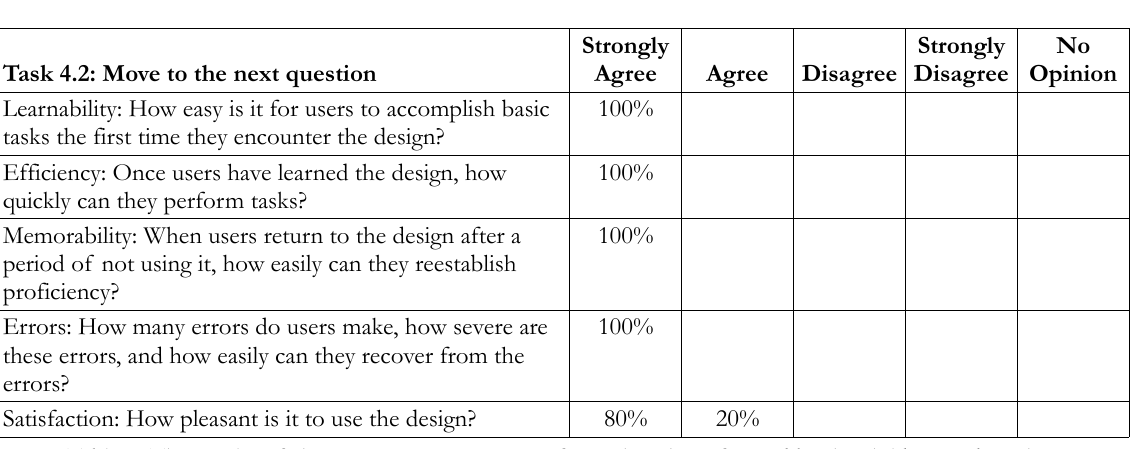
Table 6. The results of the post-test questionnaire for each task performed by the children and